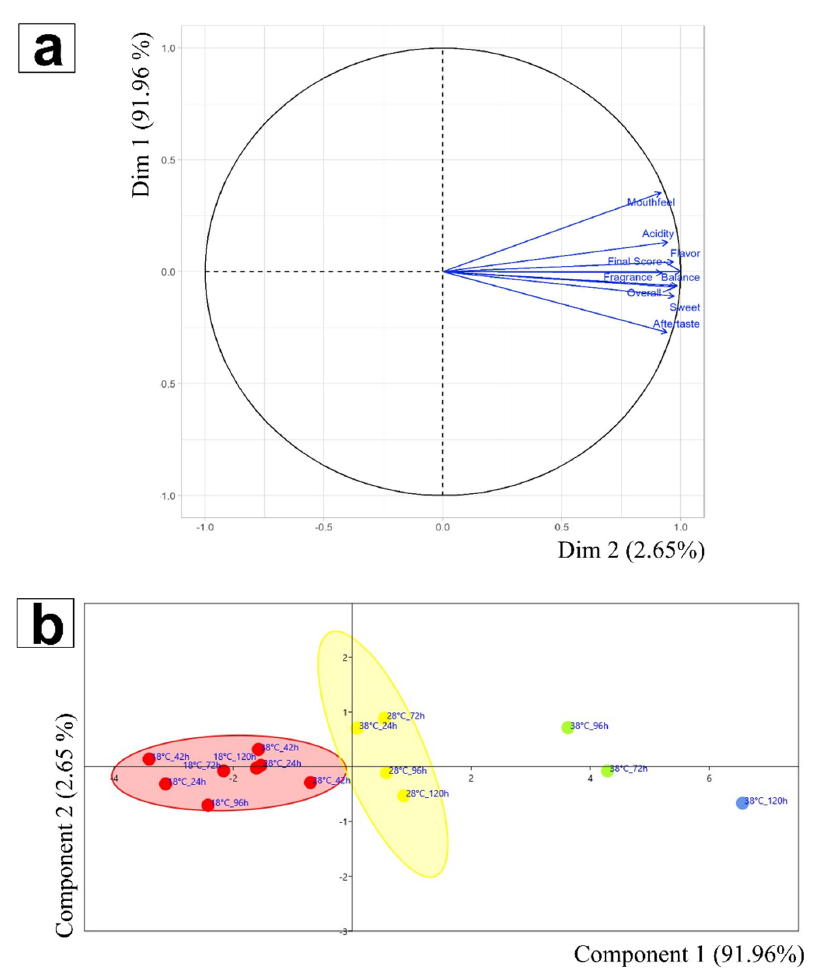
Figure 3. ( a ): Dispersion diagram ( a ) and Group categories ( b ) in relation to the first two main components, obtained from sensory characteristics, from coffees obtained from three fermentation times and 5 temperatures.